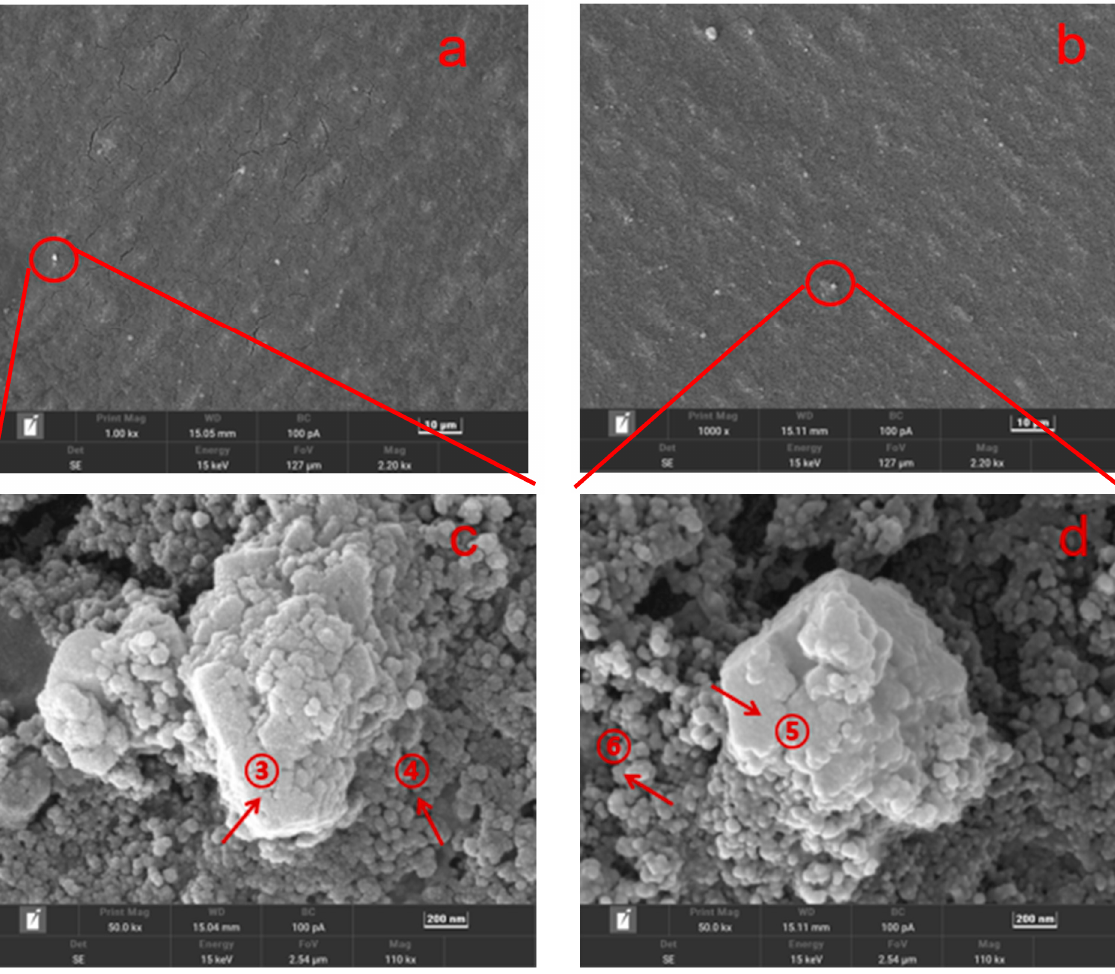
Figure 5. SEM images of fouled Vontron HOR (( a ), 1000 × ; ( c ), 50,000 × ) and DuPont Filmtec BW (( b ), 1000 × ; ( d ), 50,000 × ) RO membrane after 3 batch